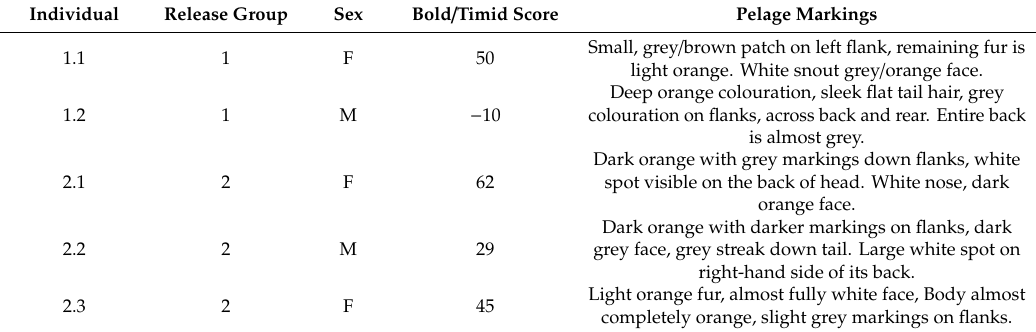
Table 1. Profiles of red squirrels studied during a translocation release in Braichmelyn Forest in 2017 showing individual boldness scores. Higher positive scores and lower negative scores are aligned with bolder or more timid individuals, respectively. The larger the - /+ score indicates how bold or timid an individual